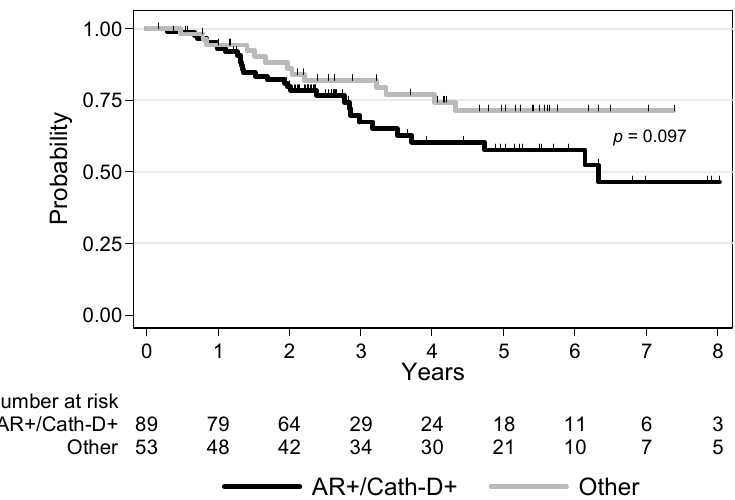
Figure 2. Recurrence-free survival in patients with non-metastatic TNBC ( n = 142) in function of AR and Cath-D co-expression. Table 3. Univariate and multivariate analyses for recurrence-free survival